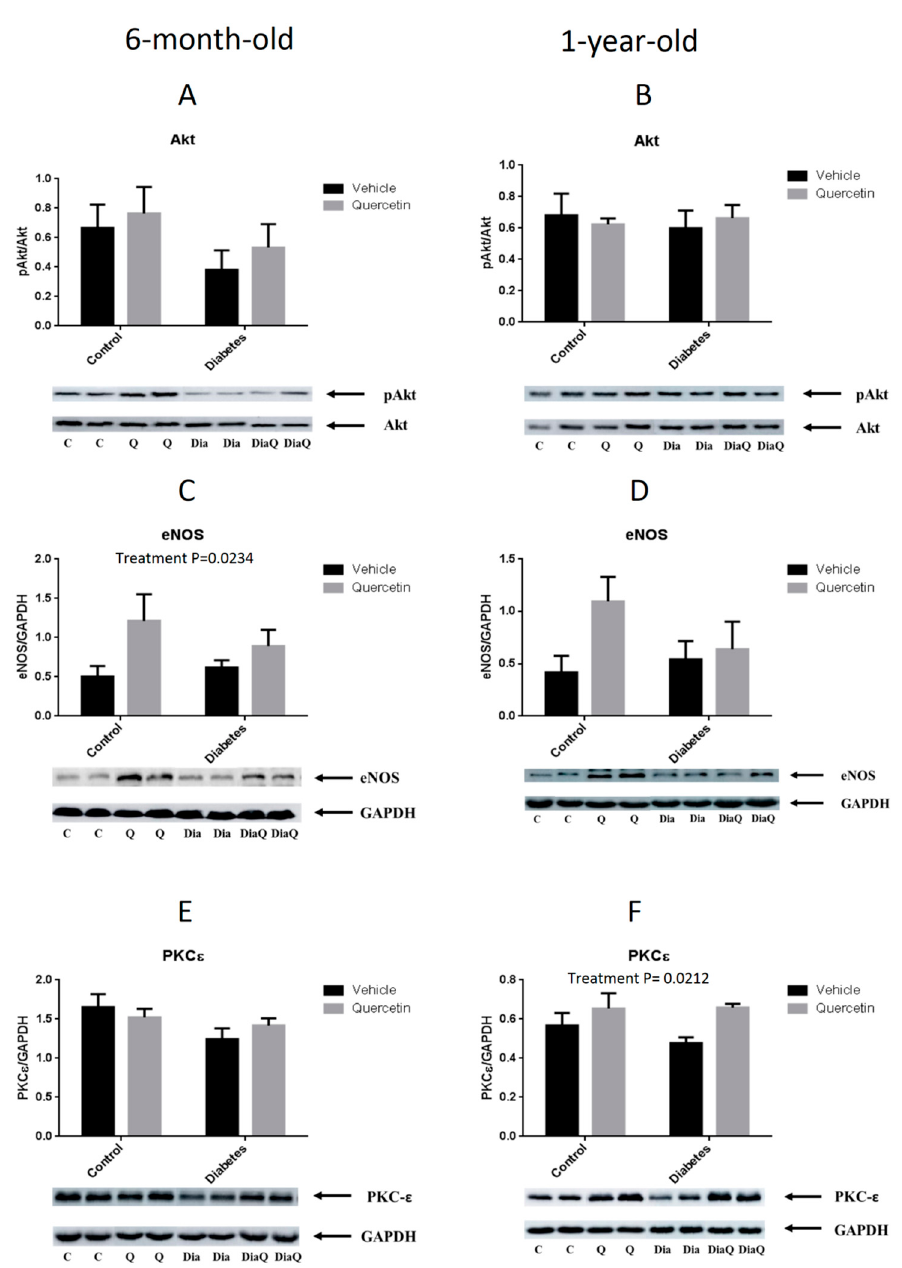
Figure 6. RISK pathway proteins expression in heart tissue E ff ect of quercetin treatment on proteins involved in the Reperfusion Injury Salvage Kinases (RISK) pathway. Levels and / or specific phosphorylation of proteins were determined by western blotting method using specific antibodies. Akt kinase activation was expressed as a ratio of Akt kinase phosphorylated at Ser473 to protein levels of total Akt kinase in younger ( A ) and older ( B ) ZDF rats. Changes in protein levels of eNOS in younger ( C ) and older ( D ) ZDF rats were normalized to the glyceraldehyde 3-phosphate dehydrogenase (GAPDH) protein levels. PKC ε protein levels were determined by specific antibody and obtained data were normalized to the GAPDH in younger ( E ) and older ( F ) ZDF rats. Results are expressed as mean ± SEM. Significant di ff erences were evaluated by two-way ANOVA for main factors diabetes and quercetin